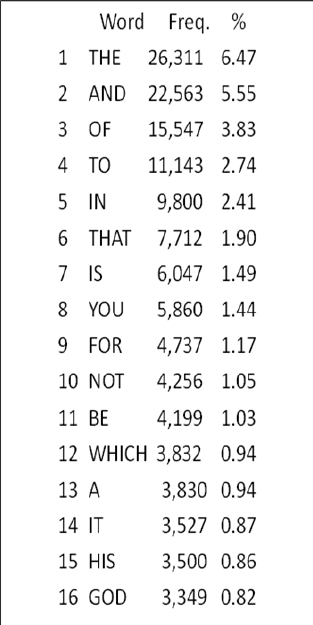
Figure 4. Wordlist generated from the Quaker corpus showing the top 16 ranked frequency items.